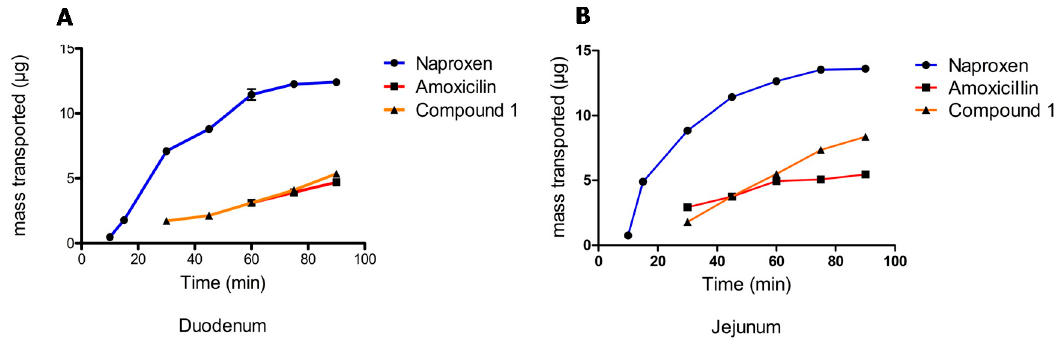
Figure 5. Permeability of Compound 1 in the everted rat gut model in the duodenum ( A ) and jejunum ( B ). Table 2. Permeability of Compound 1 in the everted rat gut model.